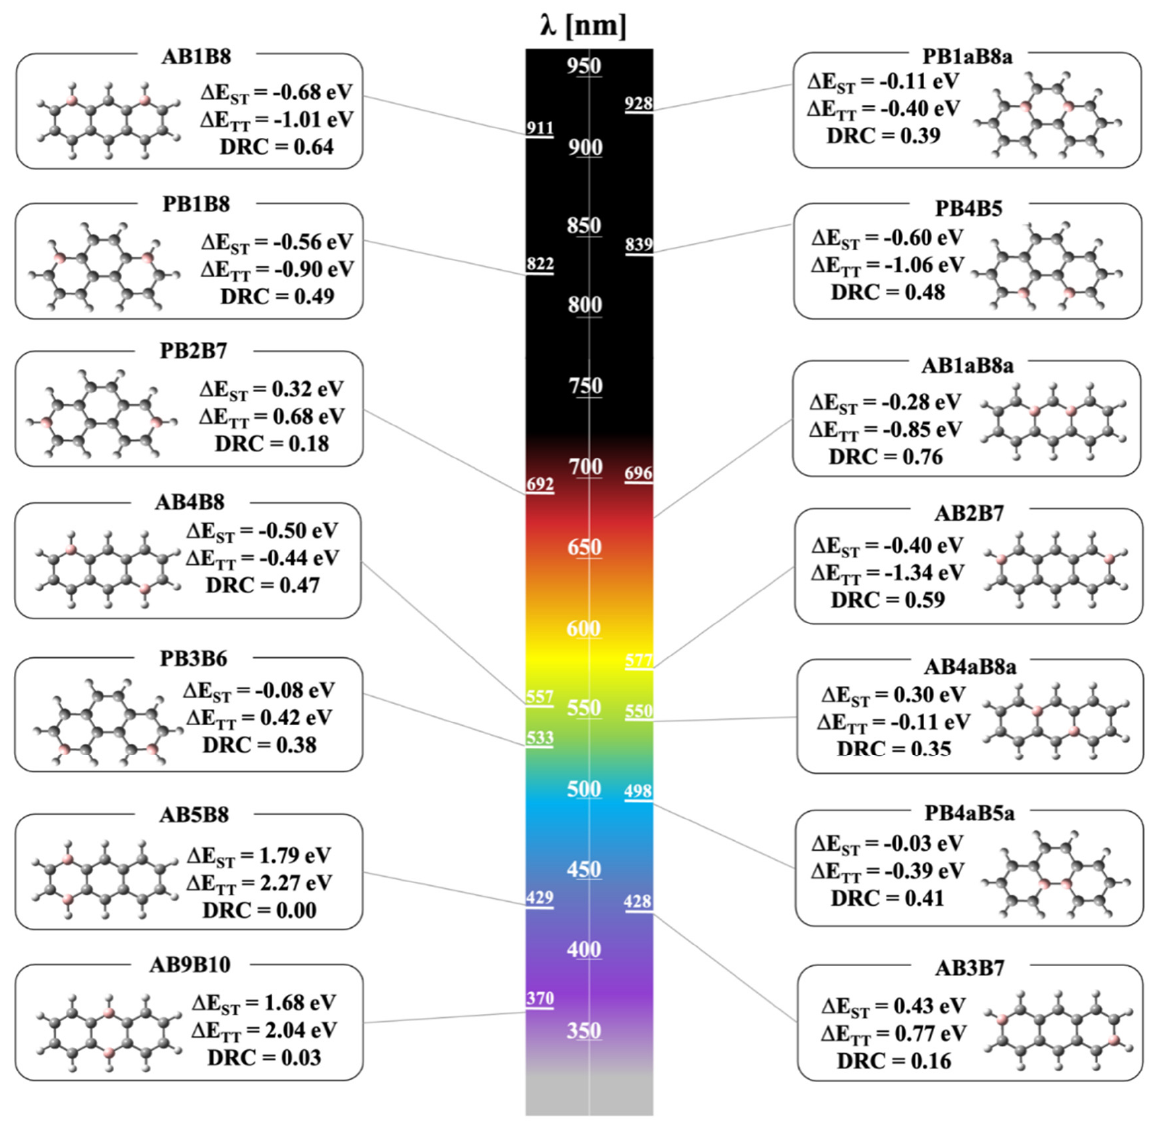
Figure 4. Molecular set investigated by J. Stoycheva et al. [63]. The compounds’ names contain the following labels: A (anthracene derivative), P (phenanthrene derivative), and B (boron), as well as numbers that show the position of the heteroatoms in accordance with the IUPAC numbering of the pristine hydrocarbons. The wavelength, λ (nm), of the first allowed for electronic transition (f ≥ 0.02), diradical character (DRC), Δ E ST (eV) = 2E(T 1 ) − E(S 1 ), and Δ E TT (eV) = 2E(T 1 ) − E(T 1 ). Reprinted with permission from [63]. Copyright 2020 American Chemical Society.